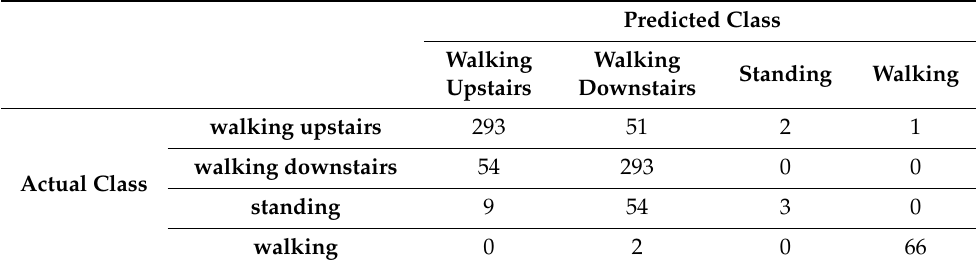
Table 9. Confusion matrix for non-normalized accelerometer data.